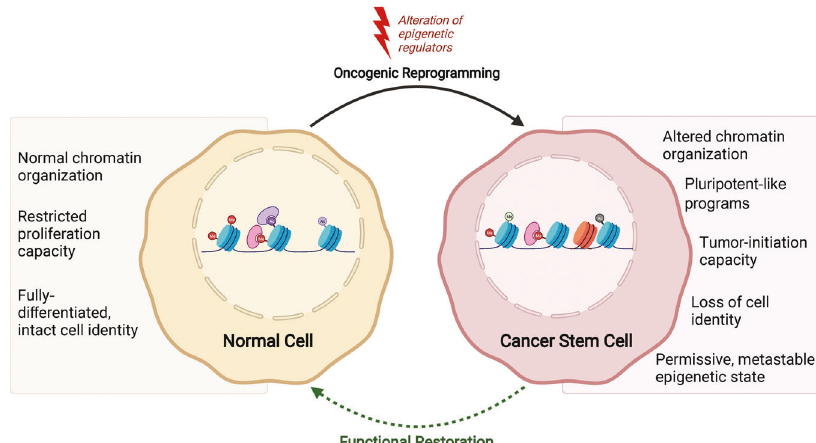
Fig. 1 Transformation-acquired epigenetic signature mediating the cancer stem cell phenotype. Misregulation of epigenetic modi fi ers is commonly observed in cancer and drives oncogenic reprogramming of healthy tissues cells (left) into CSCs (right). Therapeutic strategies targeting the CSC epigenome, via inhibition of key epigenetic regulators aim to block the biogenesis of CSC via cellular plasticity, to restore normal-like functions such as differentiation and apoptosis